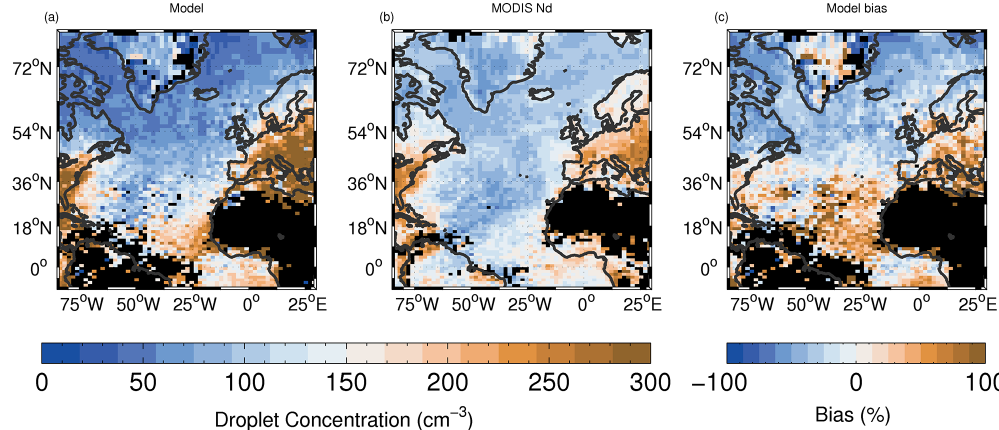
Figure 7. Time-mean model N d evaluation vs. the MODIS satellite. The model and MODIS data are restricted to data points for which the grid-box mean cloud top height is ≤ 3 . 2km and for which the liquid cloud fraction is ≥ 80%. The COSP liquid cloud fraction is used for the model screening. The arrangement of the panels is as for Fig.